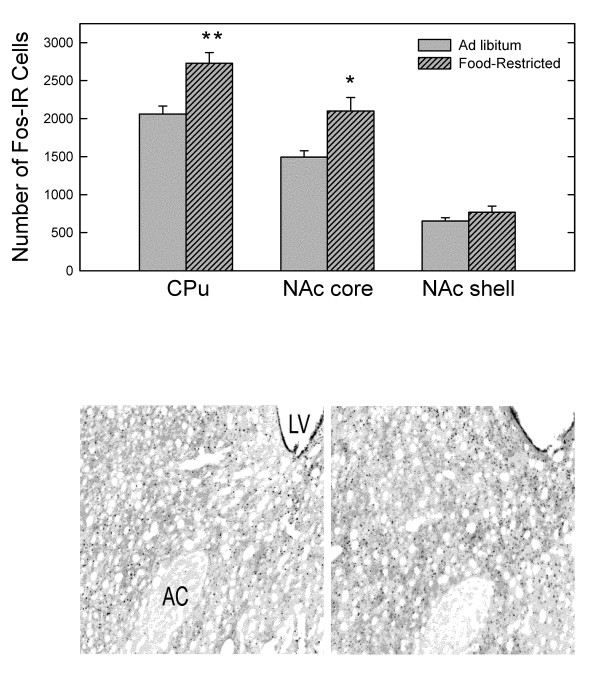
Effects of DHPG on Fos-like immunostaining in Caudate-Putamen and Nucleus Accumbens core and shell Mean (±S.E.M.) bilateral number of c-Fos immunoreactive (IR) cells within caudate-putamen (CPu) at coronal levels +1.7 and -0.3 mm (combined) and nucleus accumbens (Nac) core and shell at coronal level +1.5 mm in relation to bregma. Ad libitum fed and food-restricted rats were injected i.c.v. with DHPG (500 nmol) 90 min prior to perfusion. *p < .025, **p < .01 compared to ad libitum fed rats. Representative digital photomicrographs depicting Fos-like immunoreactivity in NAc of ad libitum fed (left) and food-restricted (right) rats are included. LV = lateral ventricle; AC = anterior commissure.